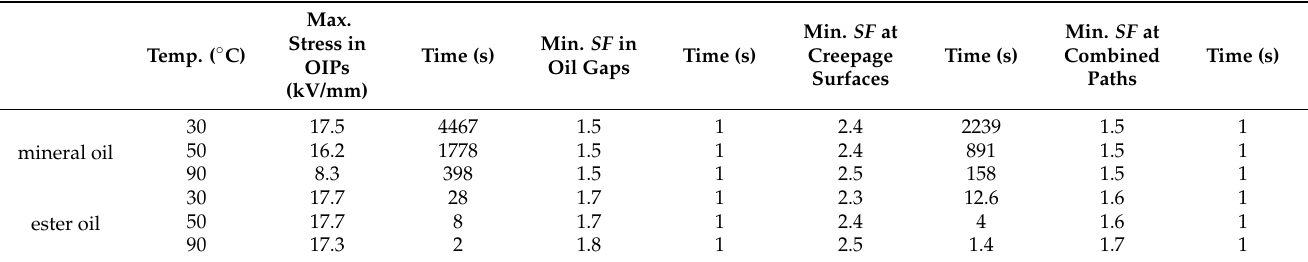
Table 3. The maximum stresses in OIPs, the minimum SF s in the oil gaps, on the interface creepage paths and combined paths and the related time of